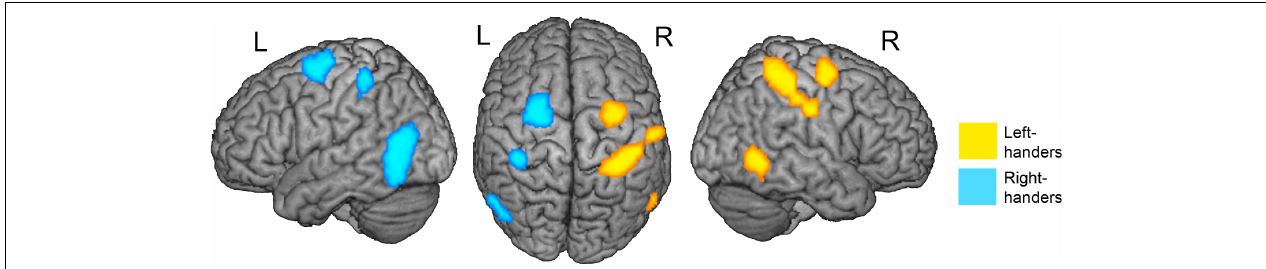
FIGURE 2 | Results from whole brain analysis for each group separately. Displayed are the results for the MAN > NONMAN comparison for left-handers (yellow) and right-handers (blue). Note the strong lateralization of responses in precentral, postcentral and inferior temporal sulcus. Results are corrected for multiple comparisons at p < 0.05